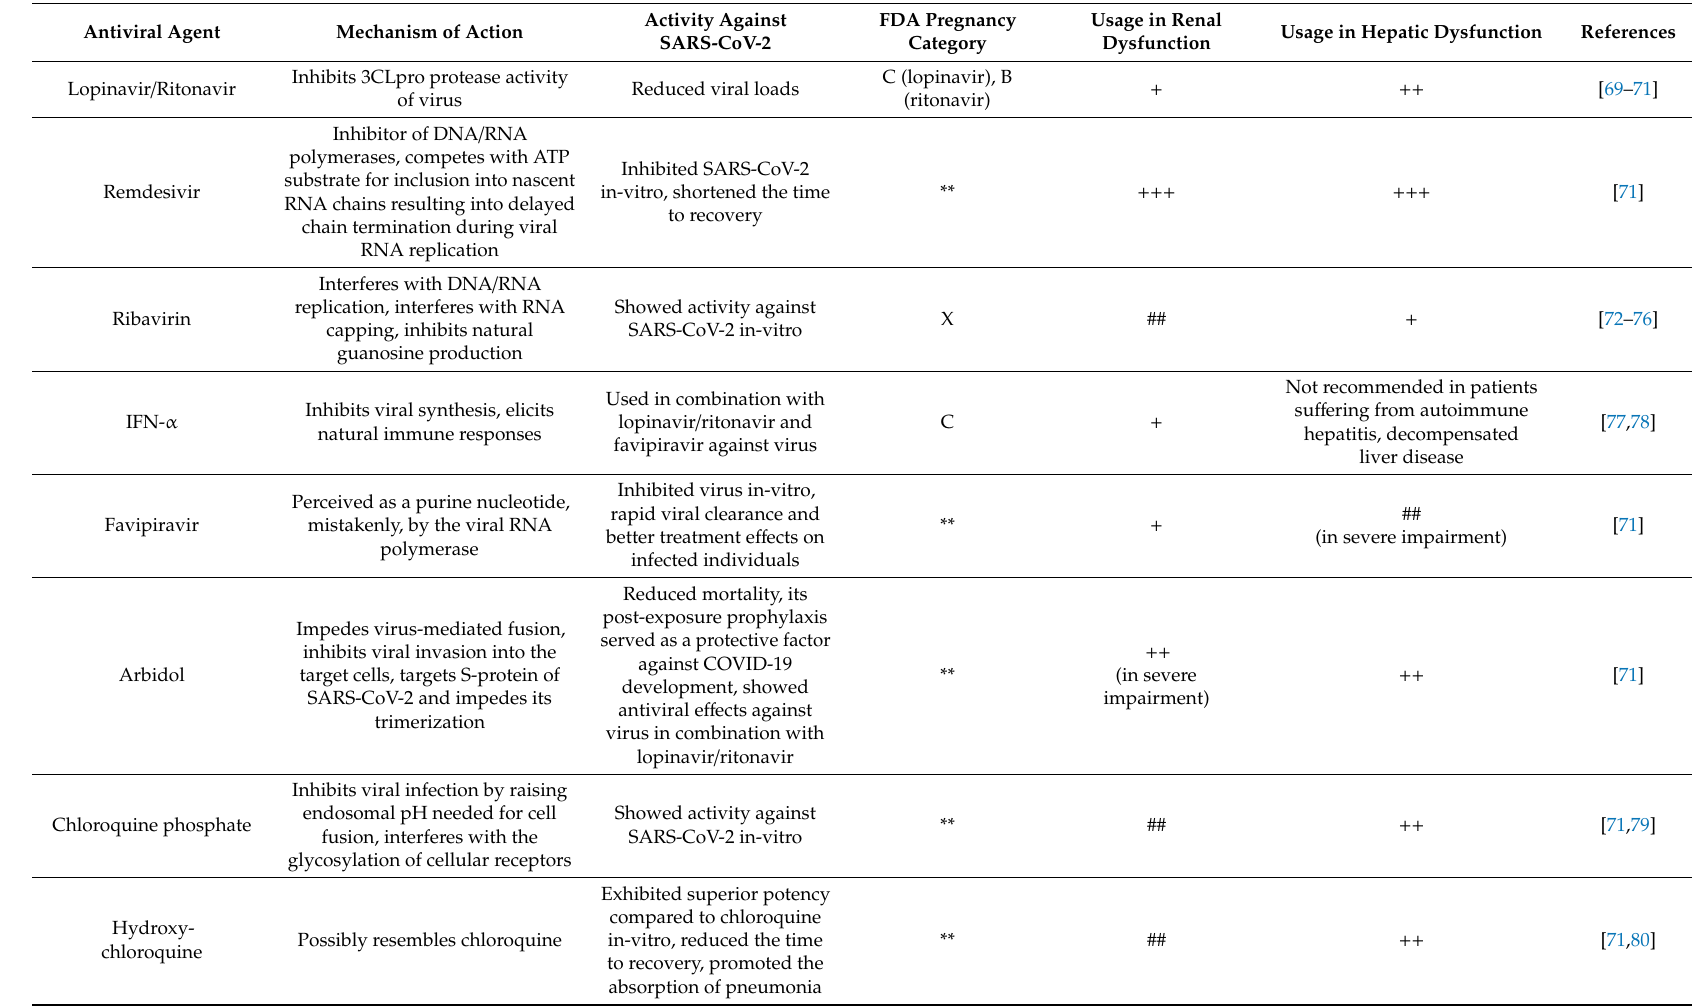
Table 2. Antiviral agents, repurposed for SARS-CoV-2